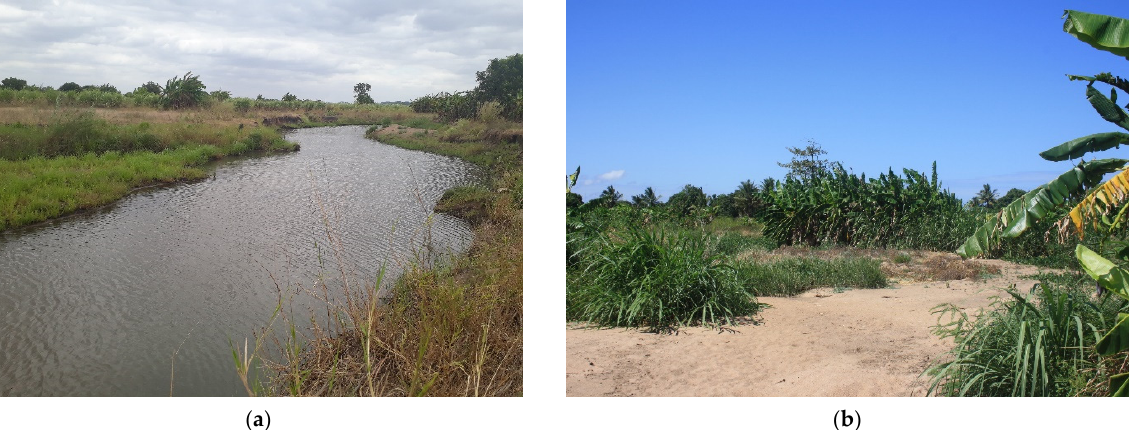
Figure 3. ( a ) A reach labelled as in very good condition with a width of 15–20 m. ( b ) A vegetated and completely buried riverbed of 5–6 m indicating a poor condition.